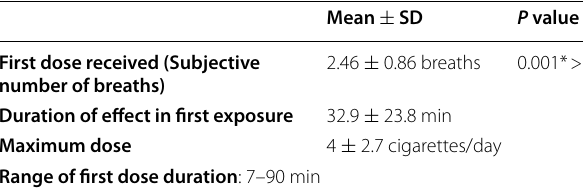
Table 5 First dose and effect duration